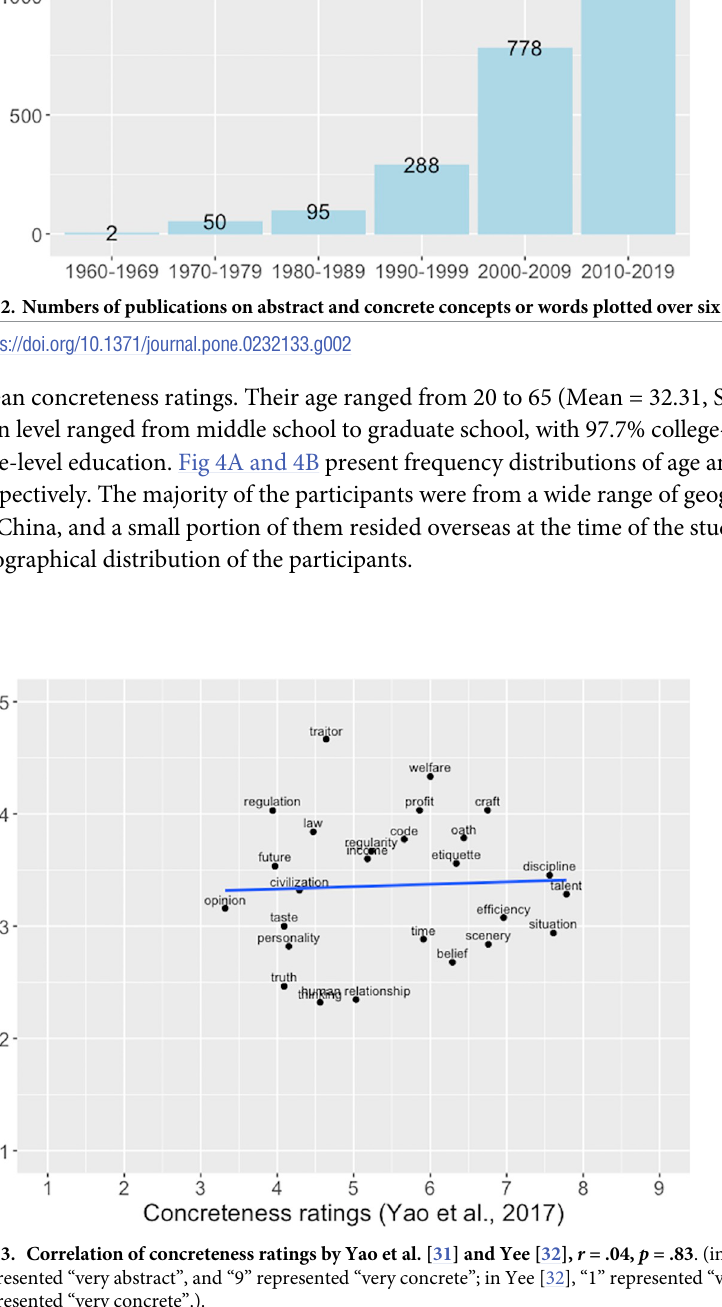
Fig 3. Correlation of concreteness ratings by Yao et al. [31] and Yee [32], r = .04, p = .83 . (in Yao et al. [31], “1” represented “very abstract”, and “9” represented “very concrete”; in Yee [32], “1” represented “very abstract”, and “5” represented “very